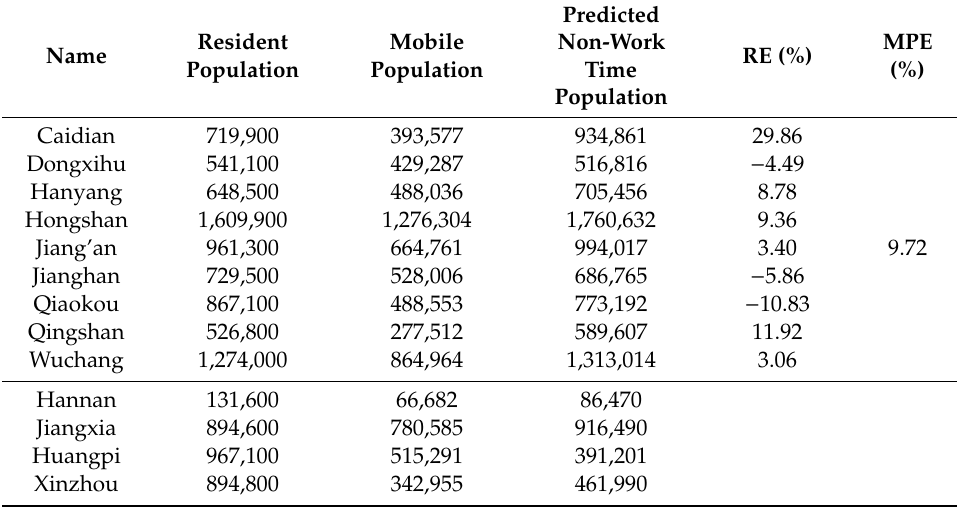
Table 9. Grid population check based on the operator’s market